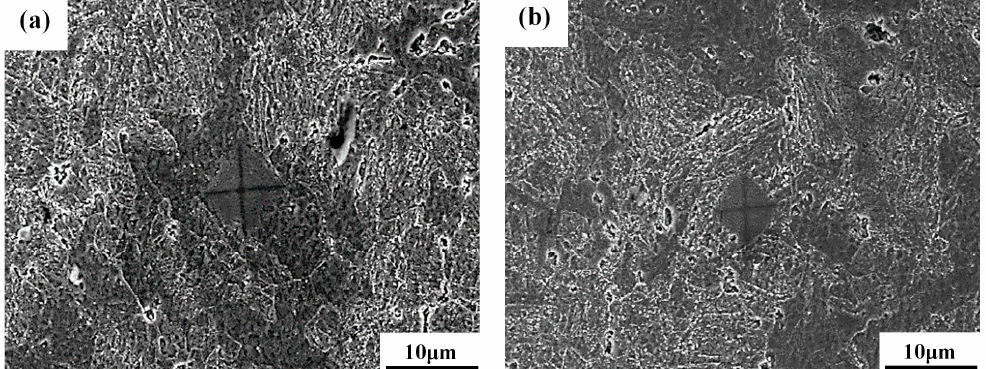
Figure 3. The hardness indentation on the ICHAZ specimen showing the differences in hardness in: ( a ) fine ferrite and ( b ) martensite.